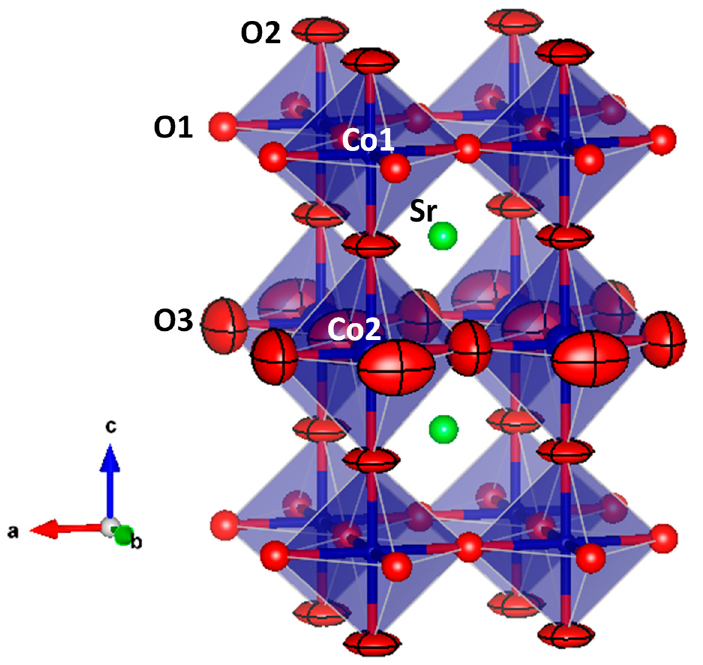
Figure 3. Tetragonal crystal structure observed for Sr 0.9 Ba 0.1 Co 0.95 Ru 0.05 O 3 −δ .